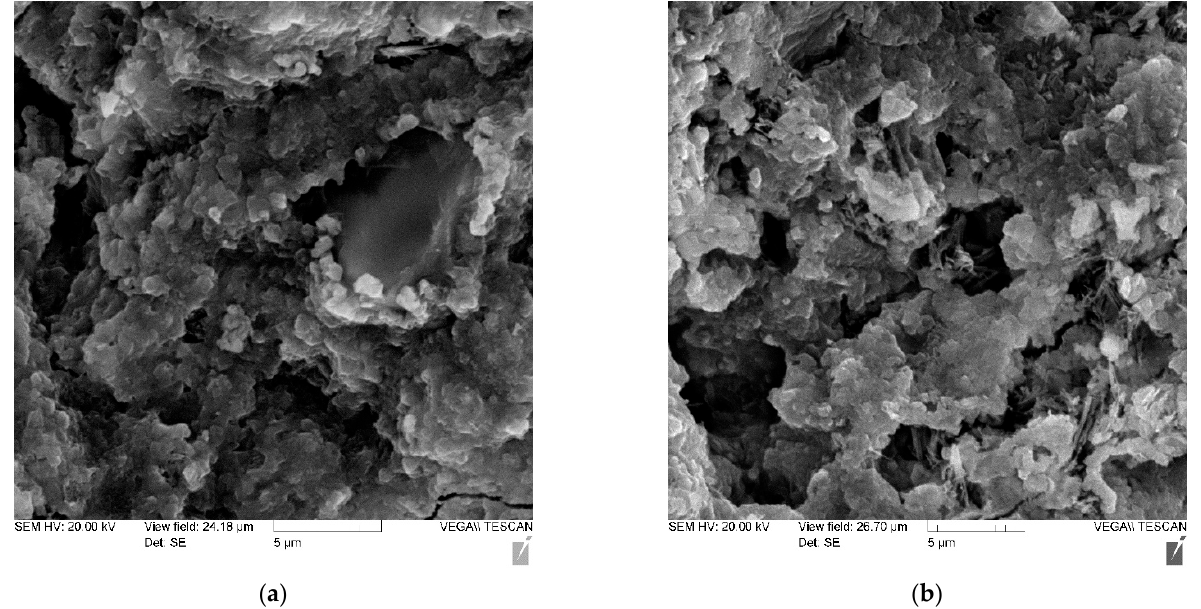
Figure 11. Photo of the microstructure of a cement stone containing an MS-85 additive in an amount of 12% and an additive of MELFLUX 5581 superplasticizer: ( a ) with 2000× magnification ( b ) with 1000× magnification.